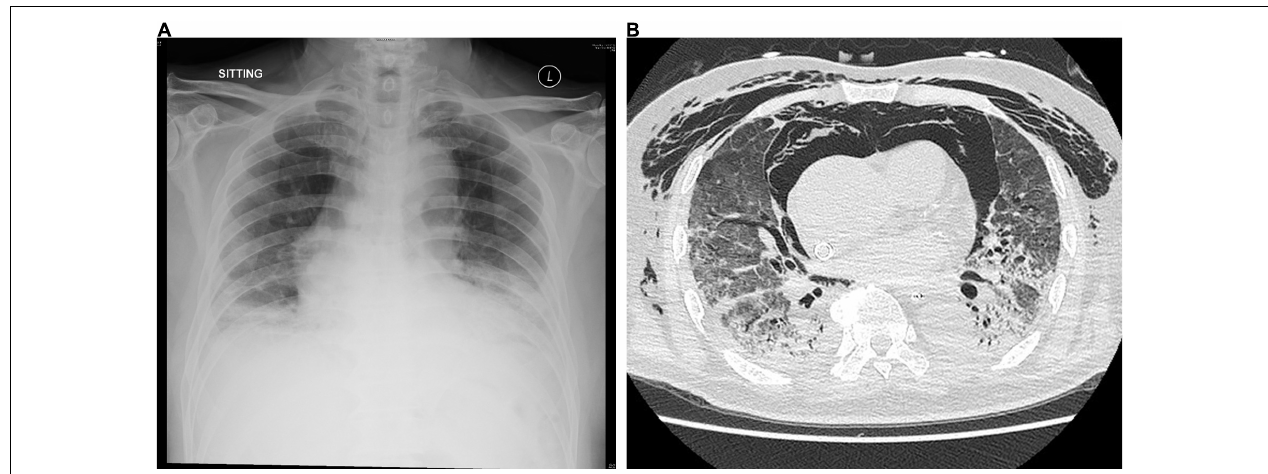
FIGURE 1 | (A) Chest radiograph on admission showing bilateral lower zone reticulonodular shadows and (B) CT scan of the thorax on day 15 showing mixed consolidative and atelectatic changes in the dependent regions of both lungs.